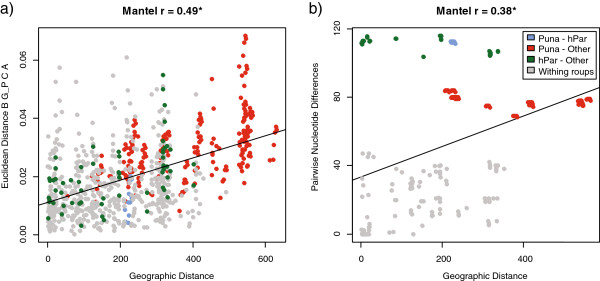
Morphological and genetic spatial isolation. Scatterplot of pairwise morphological (a) and genetic (b) distance against pairwise geographic distance between populations. Morphological distance was calculated as the Euclidean distance between population-averaged scores on the first 2 BG-PCA axes of the size-corrected shape data (see Figure 2c), whereas genetic distances was calculated as population pairwise nucleotide differences in the cytochrome-b sequences. Points are colored according to which ecosystem the populations being compared pertain (i.e., puna, high-elevation páramo, or other population). The correlation coefficient and significance of both morphological and genetic trends are presented above each scatterplot. Note that the greatest genetic distances do not correspond to comparisons involving puna populations, but to those involving high páramo populations (named hPar in legend; see Additional file 2).